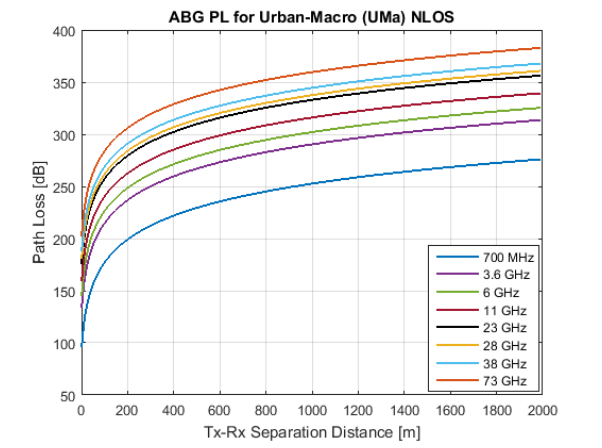
Fig 21. ABG UMa NLOS (2000 m).